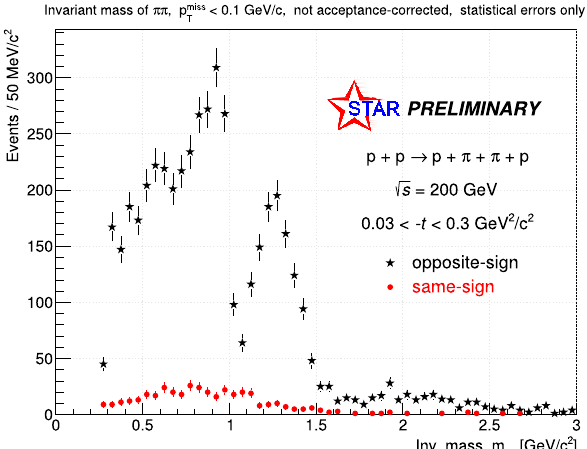
Fig. 2 InvariantmassdistributionsofpionpairsmeasuredbytheSTAR Collaboration (Figure taken from Ref. [2])